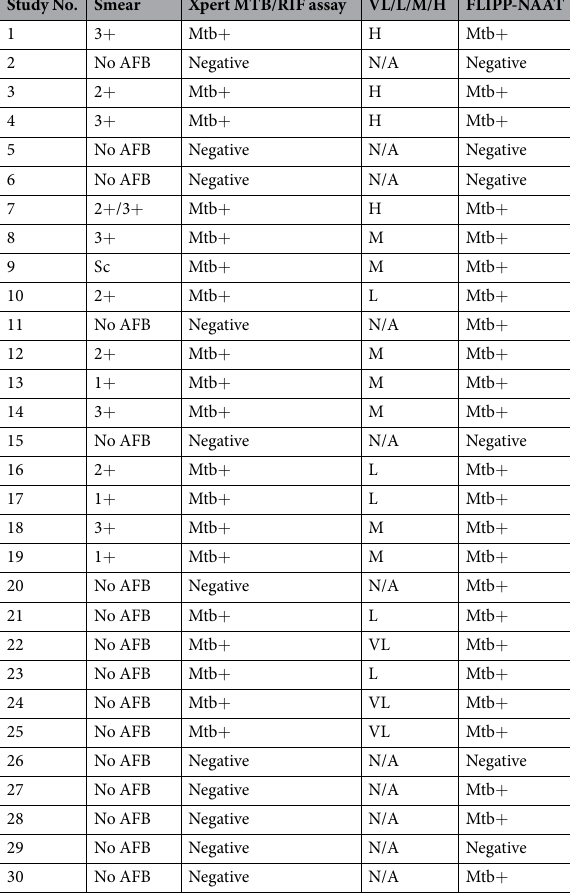
Table 1. Comparison of FLIPP-NAAT with smear microscopy and Xpert MTB/RIF. VL: Very low, L: Low, M: Medium, H: